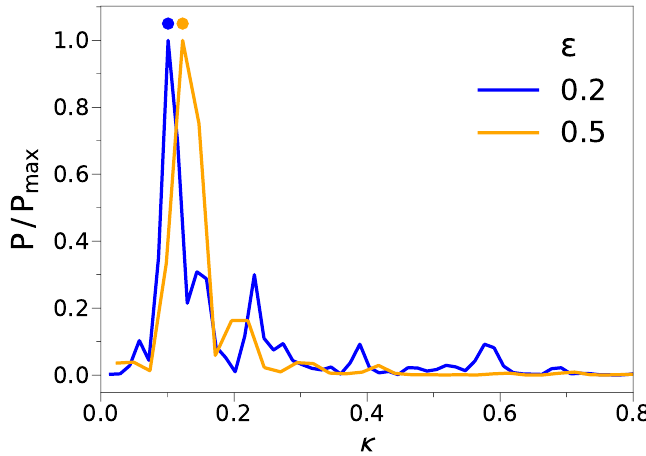
Figure 3. Normalized power spectrum of the FT of the topography of the thin film shown in Figure 2 at two different compressions. The plot gives evidence that wrinkling is characterized by a well- defined dominant wavenumber κ max (marked by a dot). The wavenumbers are in units of σ − 1 ; see Section